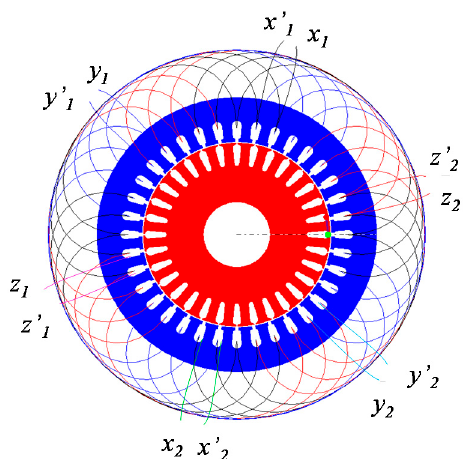
Figure 1. Structure of the six-phase copper squirrel cage rotor induction motor (SCSCRIM). Table 1. Formatted parameters of the SCSCRIM.